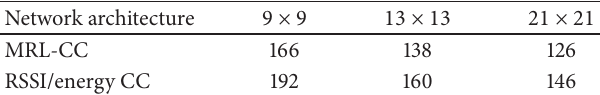
Figure 8: Network energy consumption, comparison between network architectures for MRL-CC and E/RSSI CC algorithm. Table 4: Network lifetime (in days) till the first node dies.